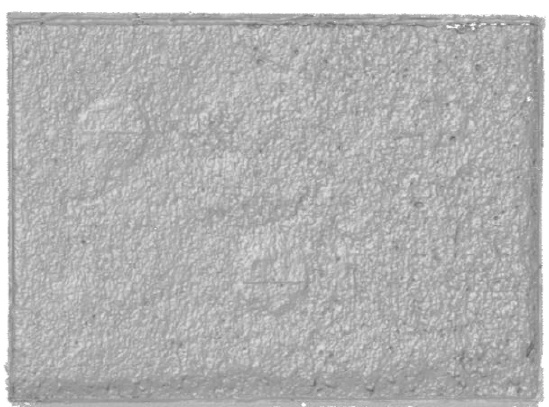
Figure 8. Structured light scanning results at the Erlenbach site. The top model shows the marble surface, the bottom model represents a concrete surface which at this point already showed erosion